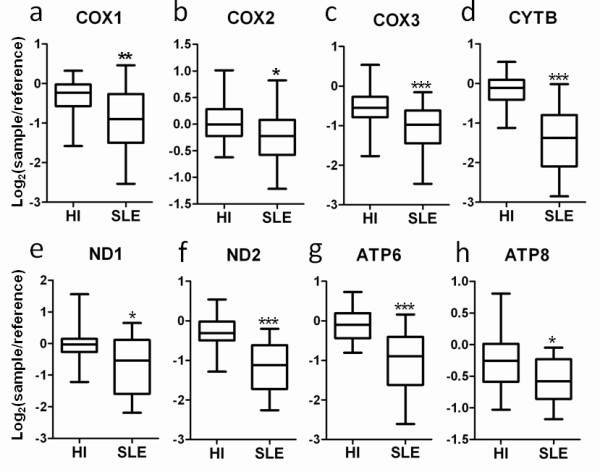
Decrease in the expressions of nine mitochondrial DNA-encoded genes. The expression levels of (a) cytochrome c oxidase (COX)1, (b) COX2, (c) COX3, (d) cytochrome b (CYTB), (e) NADH dehydrogenase subunit (ND)1, (f) ND2, (g) ATP synthase (ATP)6, and (h) ATP8 in peripheral blood of 21 patients with systemic lupus erythematosus (SLE) and 45 healthy individuals (HI) are shown. All data represent microarray data with the expression values of log2(sample/reference). *P < 0.05, **P < 0.01, ***P < 0.001 (unpaired Mann-Whitney test) for 21 SLE patients versus 45 HI. Boxes contain the 50% of values falling between the 25th and 75th percentiles, the horizontal line within the box represents the median value, and the whiskers are the lines that extended from the box to the highest and lowest values, excluding outliers.